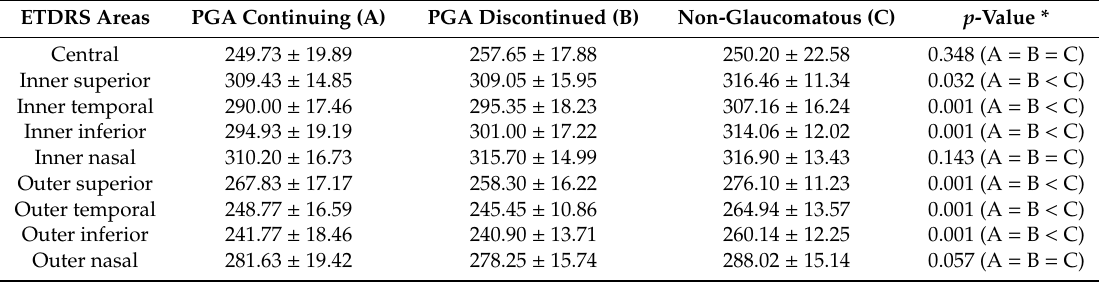
Table 2. ComparisonofpreoperativemacularthicknessesamongthePGAcontinuing, PGAdiscontinued, and non-glaucomatous